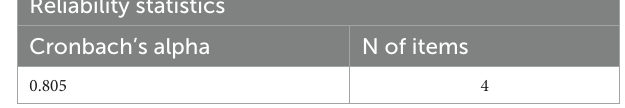
TABLE 4 Influence of corporate culture on leadership. Outcome variable: Leadership Model